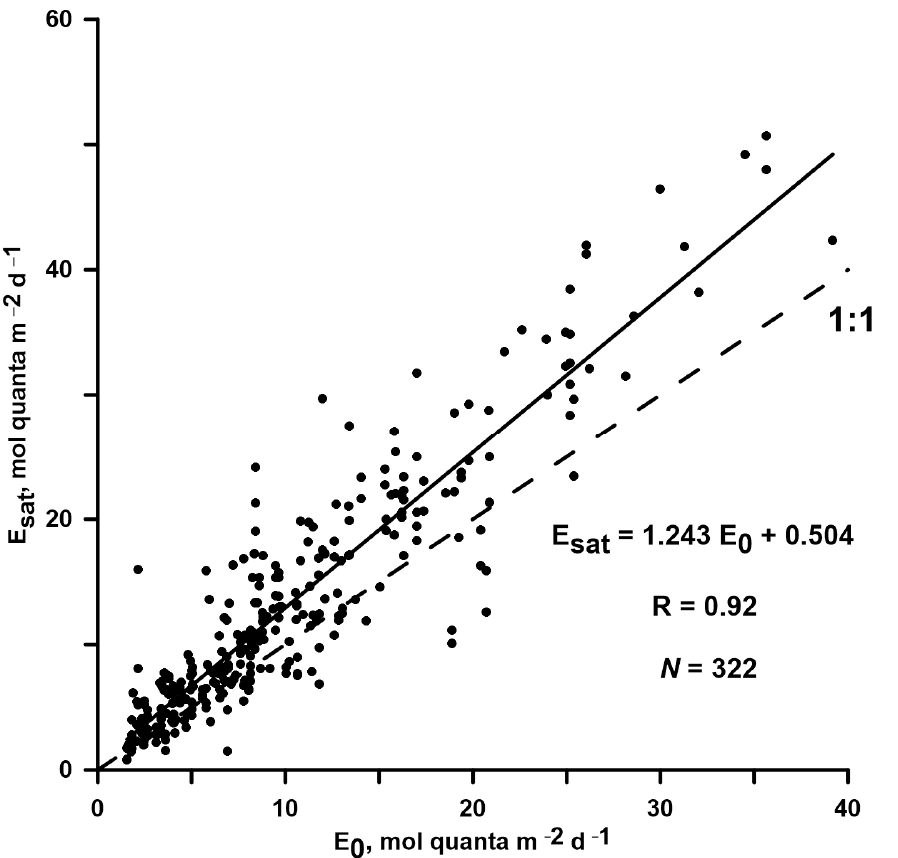
Figure 9. The relationship between measured (E 0 ) and satellite-derived subsurface PAR (E sat ) (black points). The solid line shows the line of regression. The dashed line indicates a 1:1 correlation.